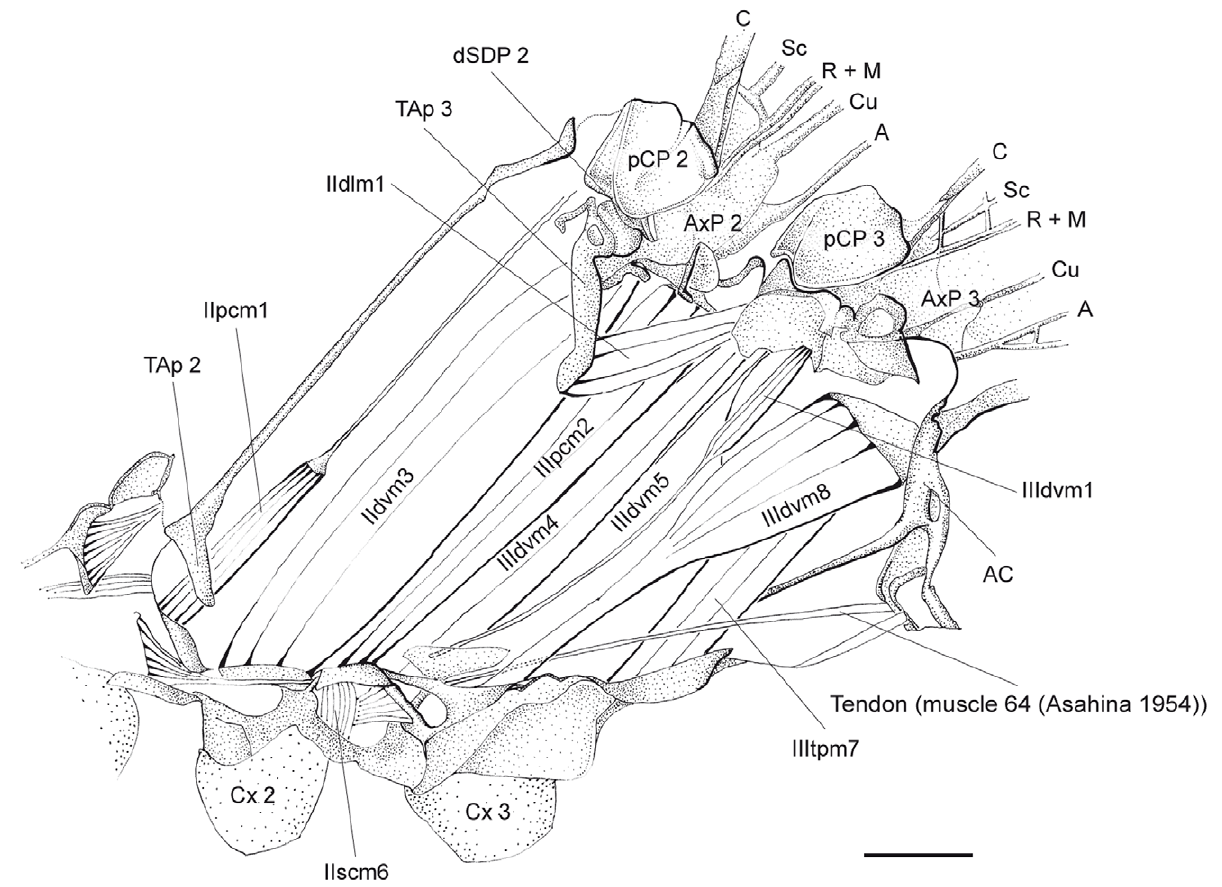
Figure 10. C.splendens , thorax musculature. Inner musculature removed, longitudinal cut, right. Abbreviations: A – anal vein, AC – antecosta, AxP – axillary plate, C – costa, Cu – cubitus, Cx – coxa, dSDP - distal semi-detached scutal plate, M – media, pCP – proximale costal plate,